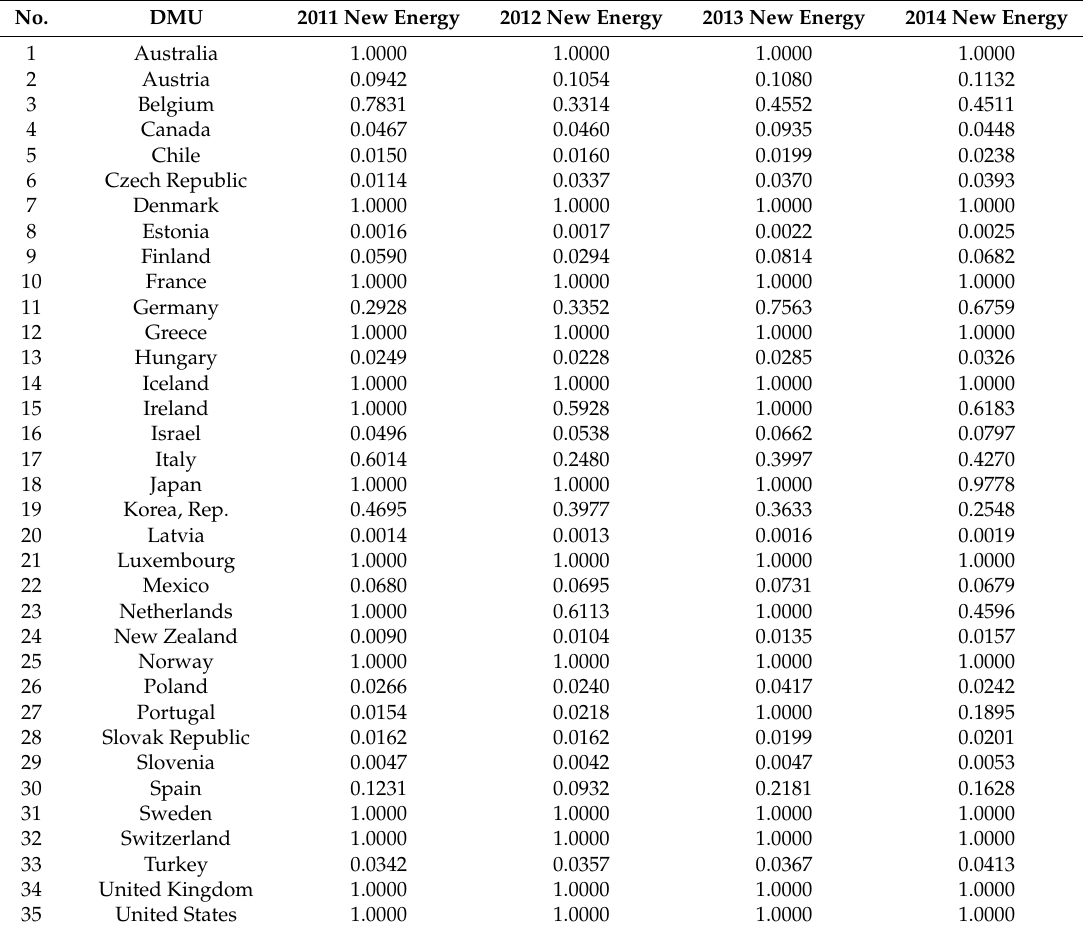
Table 6. New energy consumption efficiency from